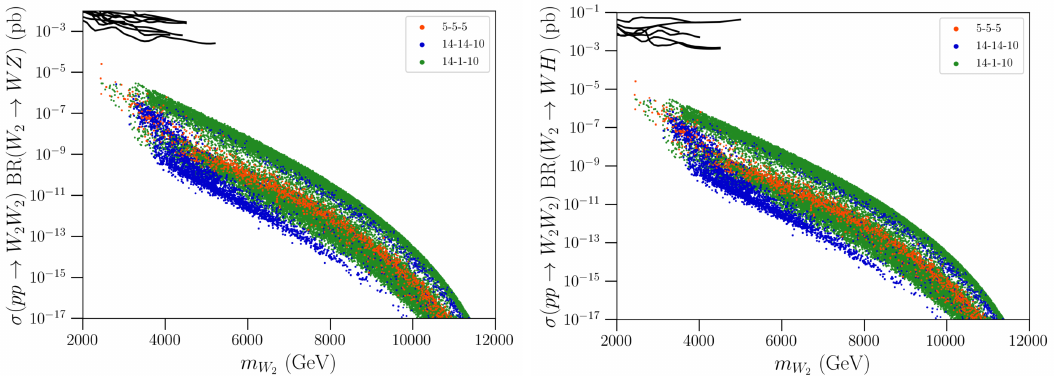
Figure 14. Cross sections for decays of the lightest charged composite vector boson W 2 into SM √ final states at s = 13 TeV for valid points in each model. Black lines mark the 95 % CL upper bounds taken as